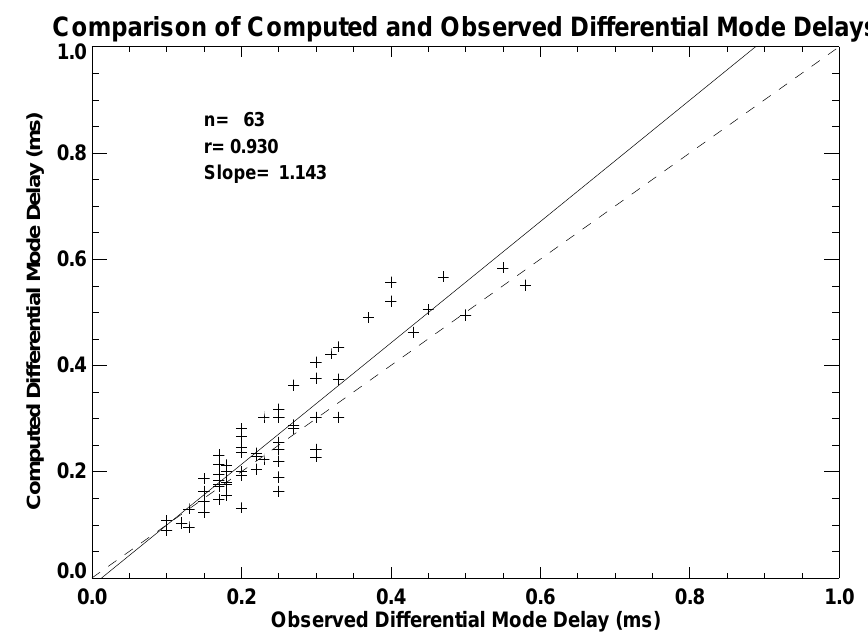
Fig. 6. A linear regression comparison of all simulated and observed differential mode delays for the ISIS II experiment. The dashed line is the ideal fit and the solid line is the best fit. The regression analysis used 63 points and gave a regression coefficient of 0.930 and a slope of